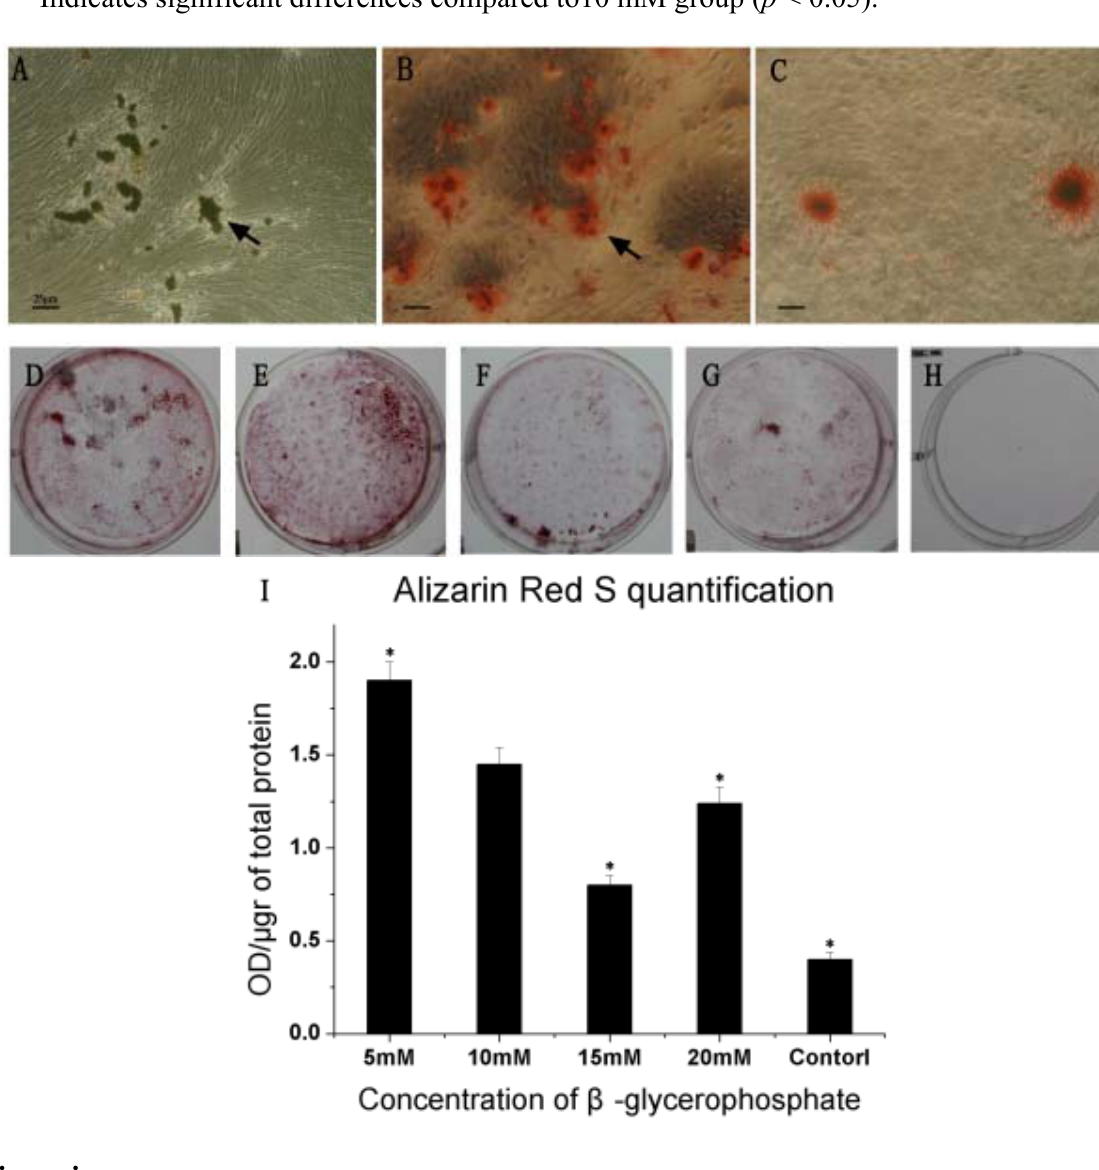
Figure 5. Cell morphology and mineralized nodules of human dental pulp cells maintained in mineralized medium for 28 days. ( A ) Arrow shows the cells started to form an aggregated center after the mineralized culture (original magnification, ×40). ( B ) Arrow shows the cells stained by Alizarin red S cultured in mineralized groups, (original magnification, ×40). ( C ) Cells stained by Alizarin red S cultured in control group (original magnification, ×40). ( D–H ) 5 groups of cells stained by Alizarin Red S shows that 5 mM β -glycerolphosphate group form more mineralized nodules. ( I ) Quantification of Alizarin Red S at 28th day. Data are shown as mean OD/µg of total protein ± SD (n = 6). * Indicates significant differences compared to10 mM group ( p <